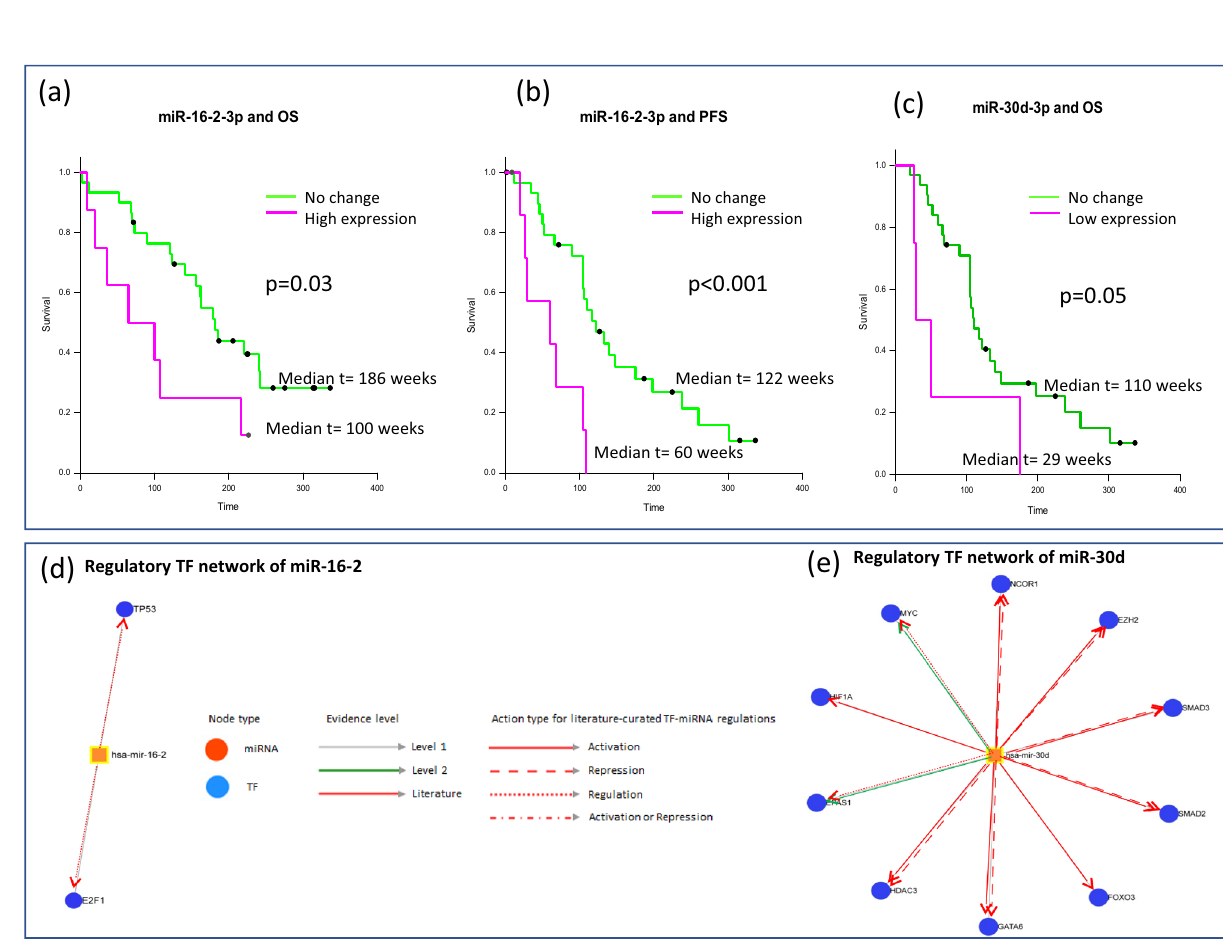
Figure 4. Kaplan Meier plots showing associations of ( a ) miR-16–2-p with OS, ( b ) miR-16–2-3p with PFS and ( c ) miR-30d-3p with OS. Regulatory transcription factor networks of miR-16–2 and of miR-30d are shown in ( d ) and ( e )